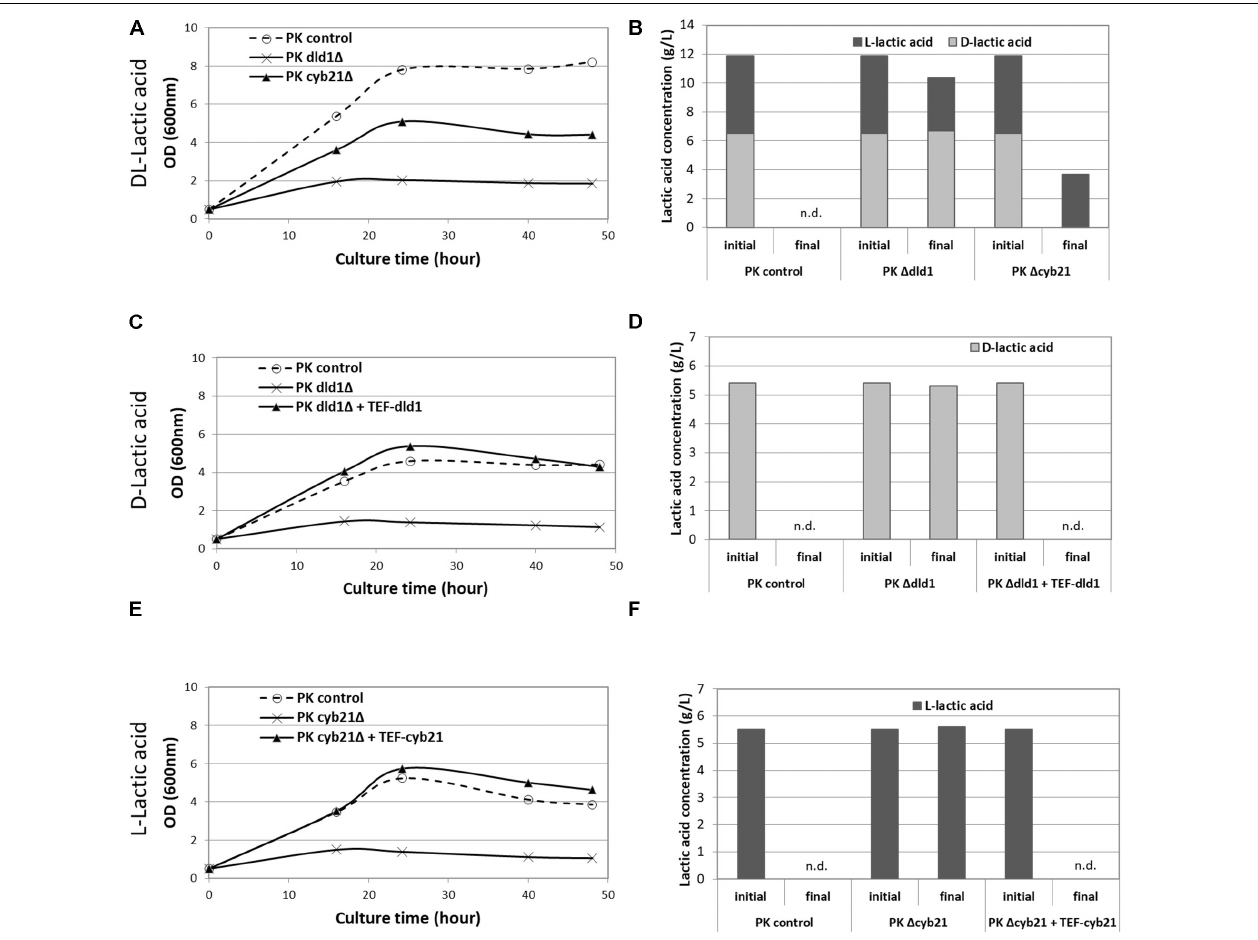
FIGURE 1 | Growth curves of strains with lactate dehydrogenase deletion and lactic acid consumption. Growth curves of PK control strain, PK dld1 (cid:49) and PK cyb21 (cid:49) strains with DL -lactic acid as carbon source (A) , and their lactic acid consumption (B) ; PK control strain, PK dld1 (cid:49) and PK dld1 (cid:49) + TEF-DLD1 strains on D -lactic acid (C) and their D -lactic acid consumption (D) ; PK control strain, PK cyb21 (cid:49) and PK cyb21 (cid:49) + TEF-CYB21 strains on L -lactic acid (E) and their L -lactic acid consumption (F) . Data presented are representative of at least three independent experiments. n.d., not